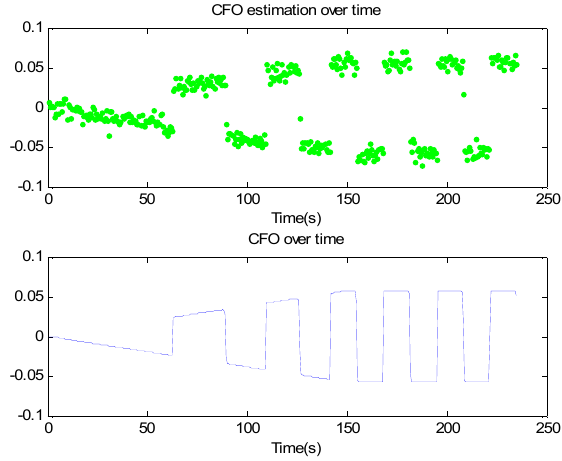
Figure 8. CFO estimation over time with the acceleration of a = 0.5 m / s 2 .